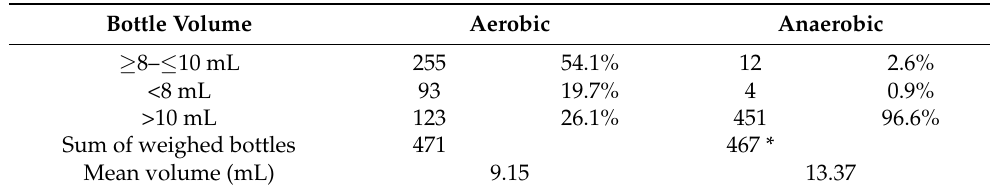
Table 2. Blood volume of aerobic and anaerobic blood culture bottles at the post-interventional study